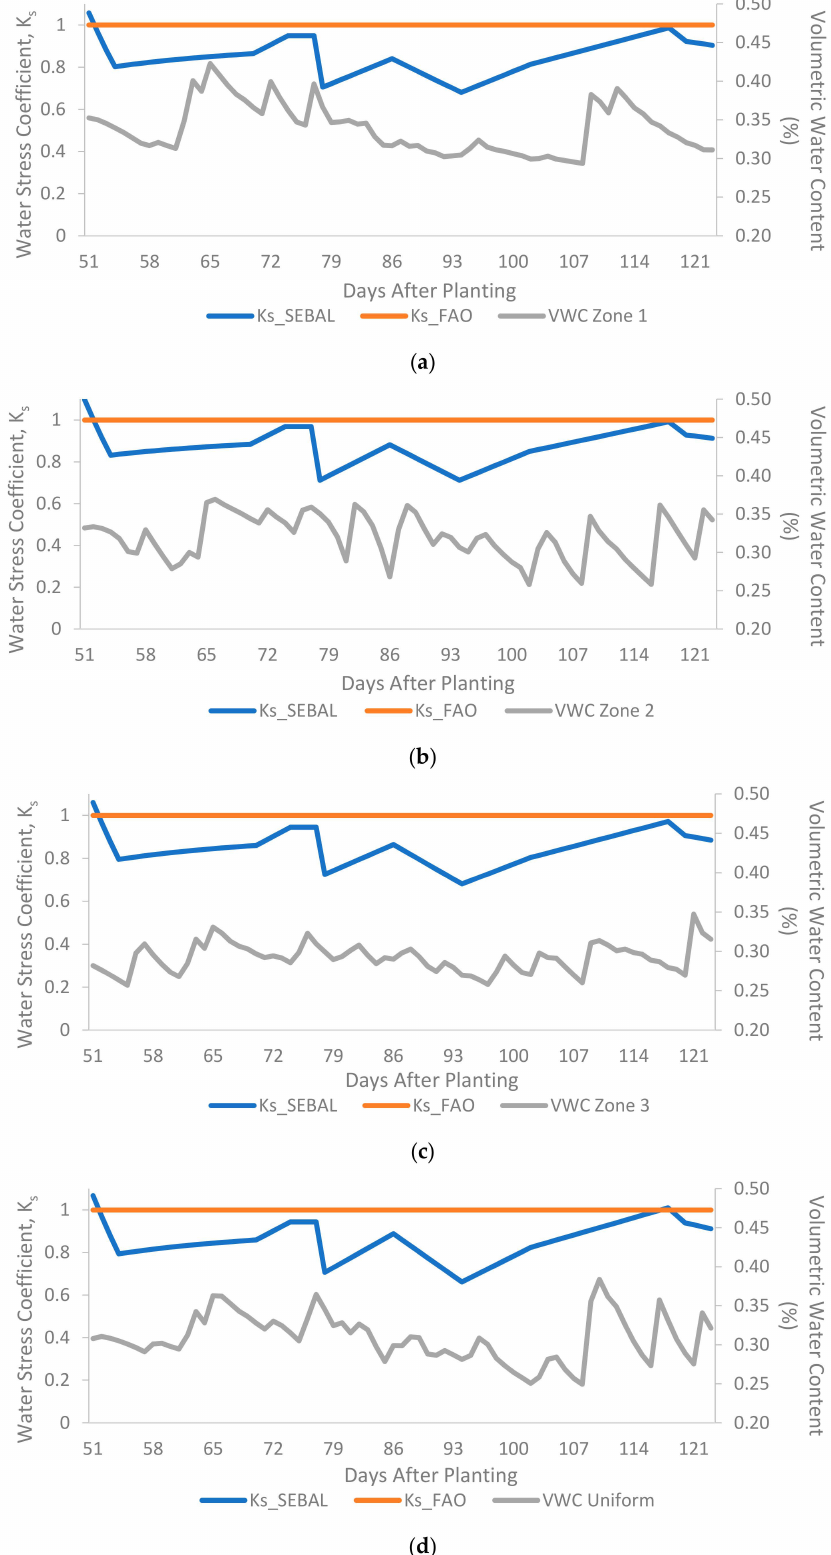
Figure 11. Volumetric water content (VWC), FAO-56 and SEBAL-based water stress coe ffi cients (K s ) calculated over the 2015 growing season for zone 1 ( a ), zone 2 ( b ), zone 3 ( c ) and the uniform irrigated area ( d